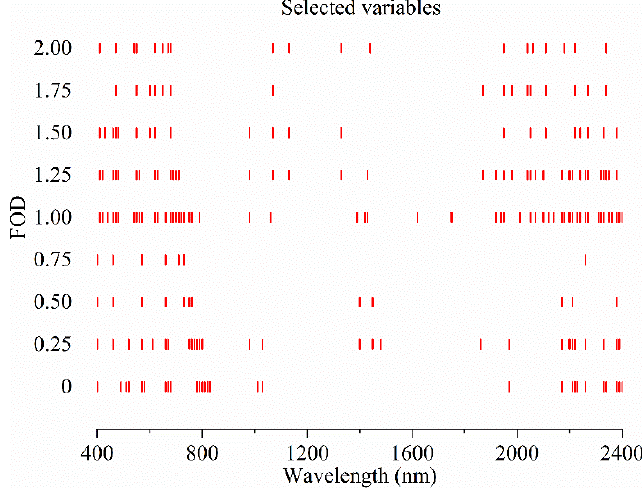
Figure 6. The distributions of spectral variables selected by CARS method at different derivative orders.